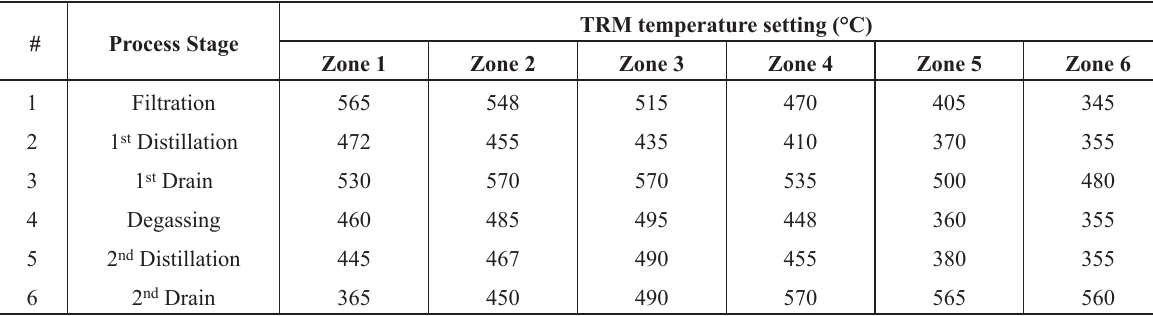
Table 2. Experimental TRM temperatures for Te refinement